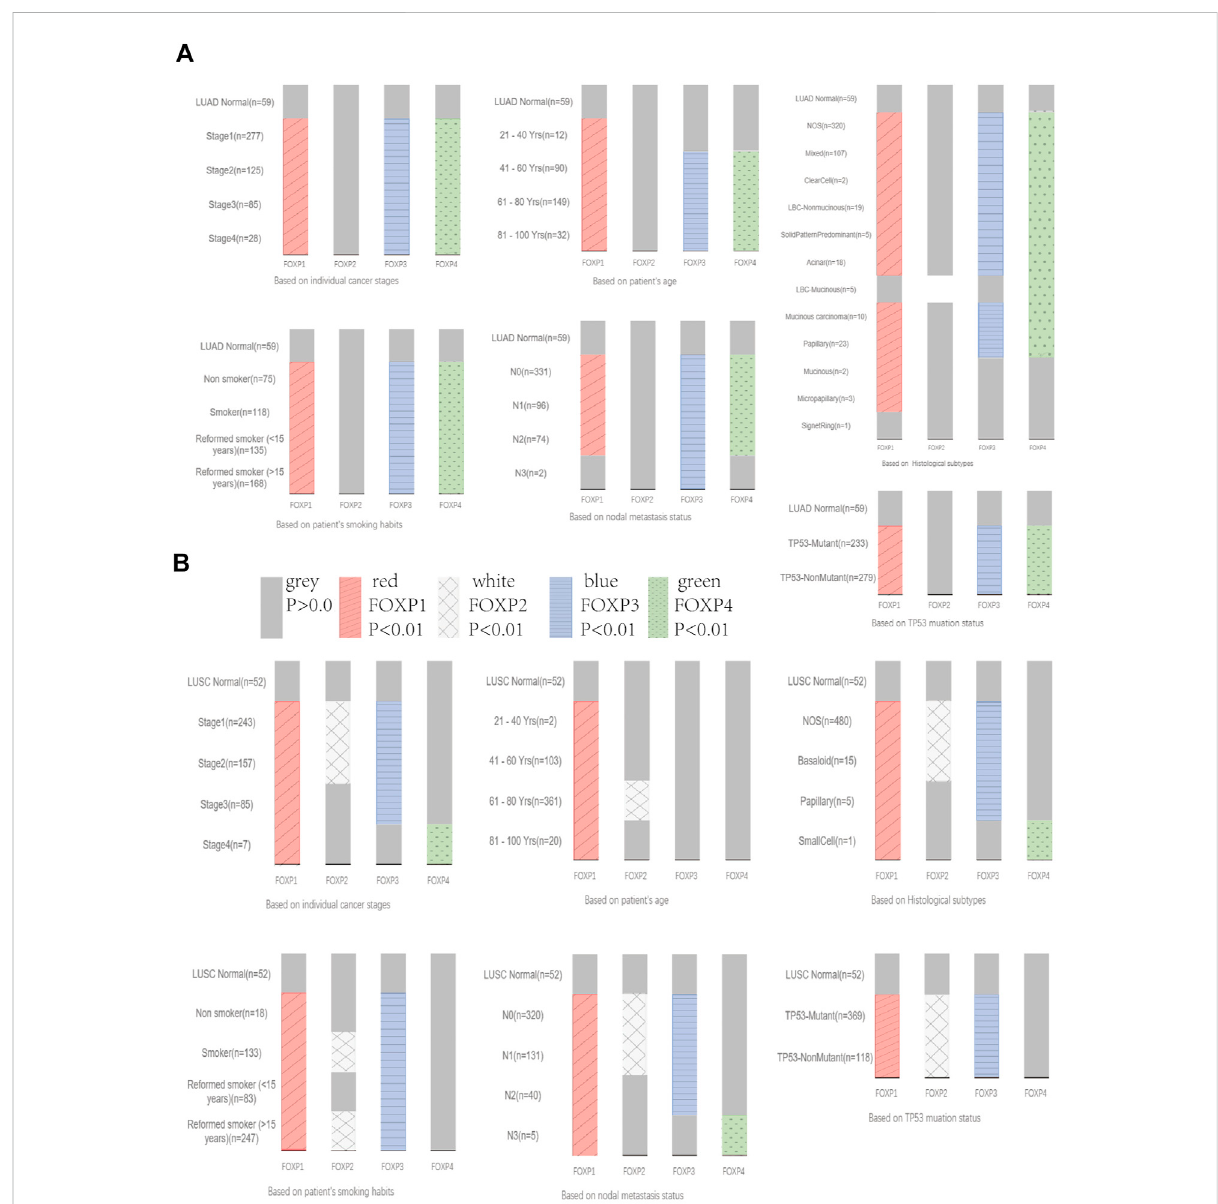
FIGURE 3 The relationship between the expression levels of FOXP family and clinicopathological stages. (A) The Bar graphs showing the expression of FOXP family differences between the clinicopathological stages of LUAD and normal tissues. (B) The Bar graphs showing the expression of FOXP family differences between the clinicopathological stages of LUSC and normal